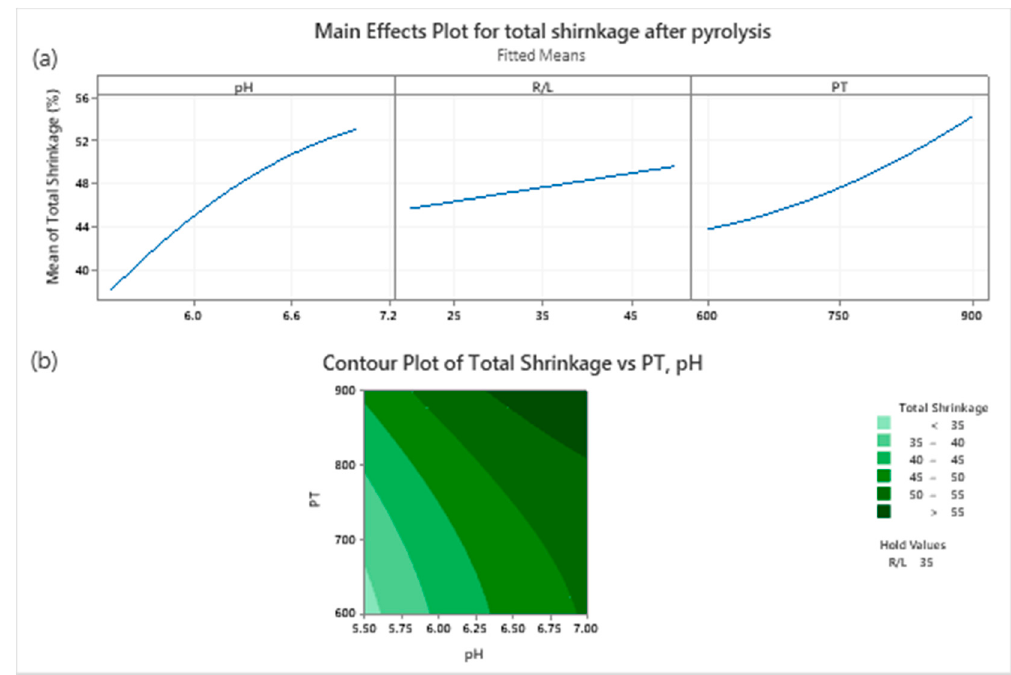
Figure 3. RSM main effect ( a ) and contour plots ( b ) for the total shrinkage of the carbon